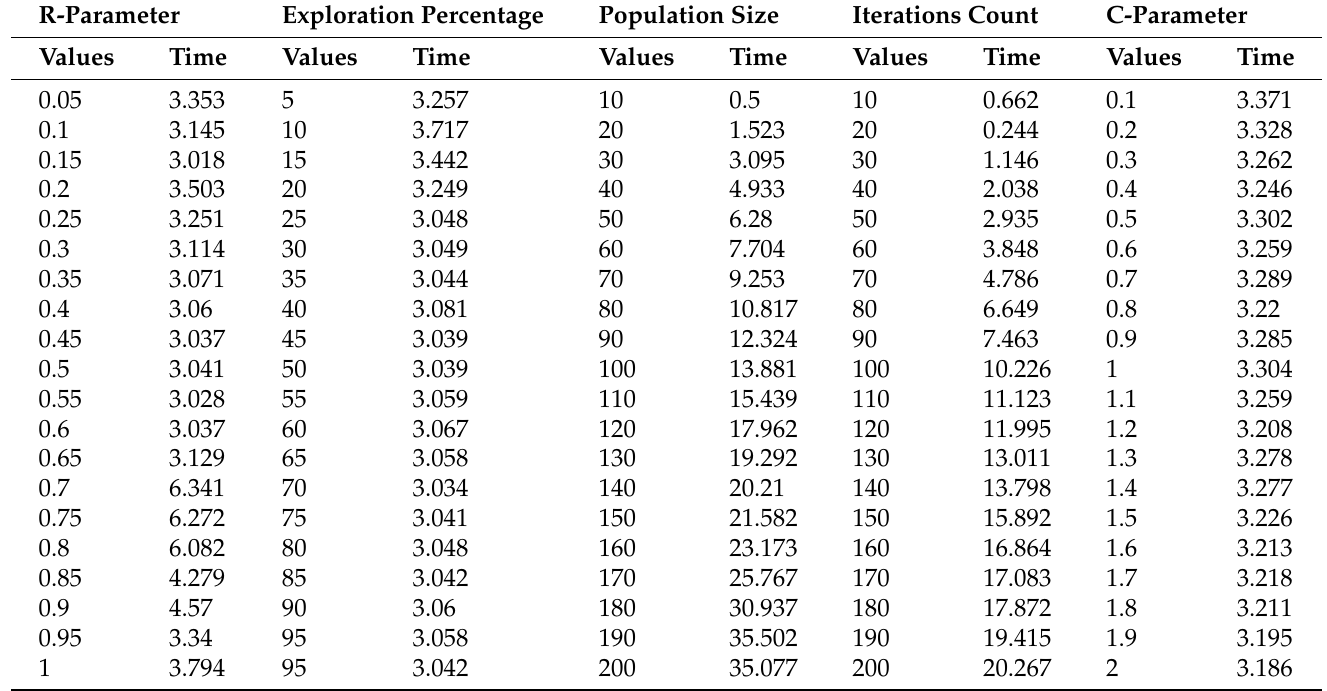
Table 15. Convergence time results for different values of the GSDTO’s parameters.